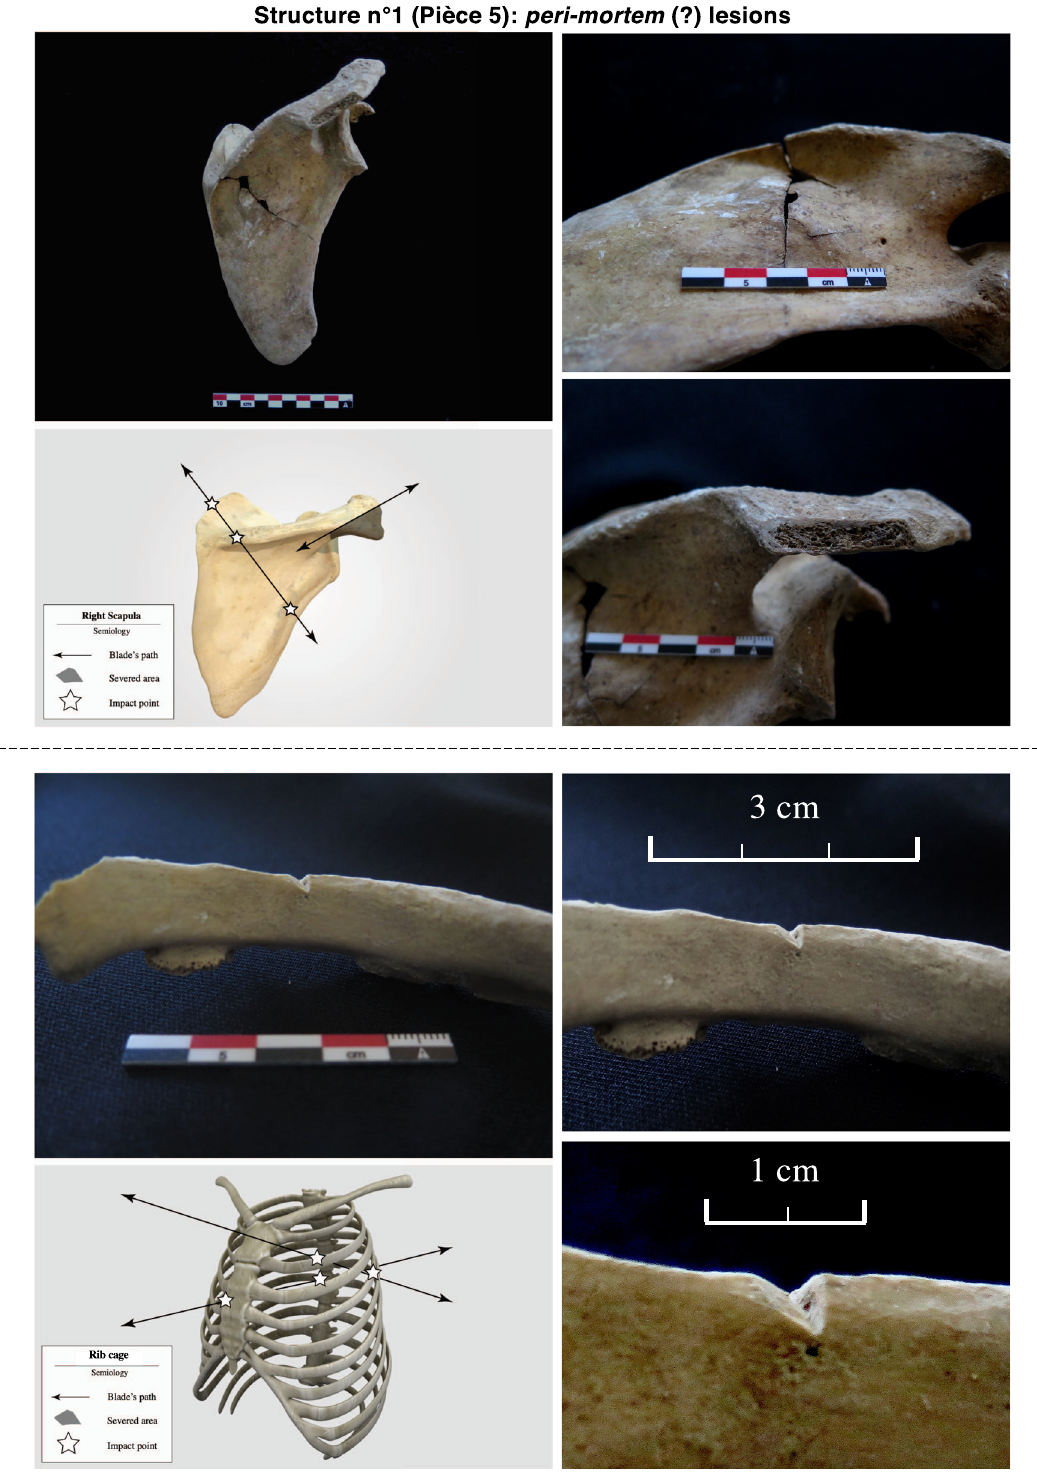
Figure 8: Peri - mortem ( ? ) lesions on an adult right scapula ( top ) and an adult left rib ( bottom ) . Photographs by Hofstetter ( 2016 )